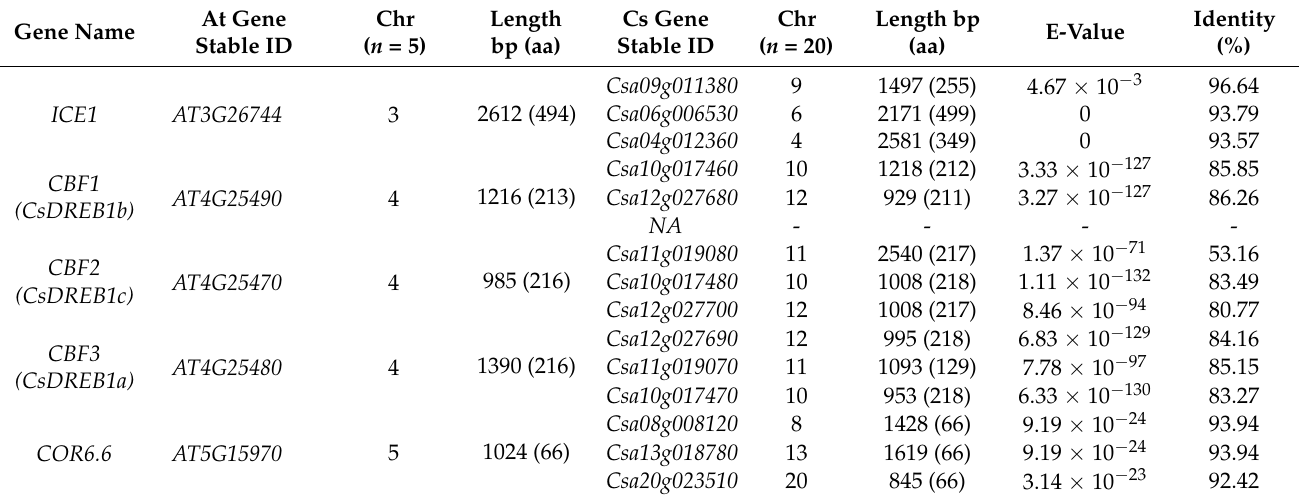
Figure 2. The CsICE1 , CsCBF1 , CsCBF2 , CsCBF3 , and CsCOR6.6 genes in two Camelina biotypes (freezing sensitive (FS) and freezing tolerant (FT)) with (AC) and without cold acclimation (NA) after freezing stress. The ns, *, **, and *** show non-significant differences or significant differences at p ≤ 5%, 1%, and 0.1%, respectively. Table 1. Comparison of the selected ICE-CBF-COR genes in A. thaliana and C. sativa